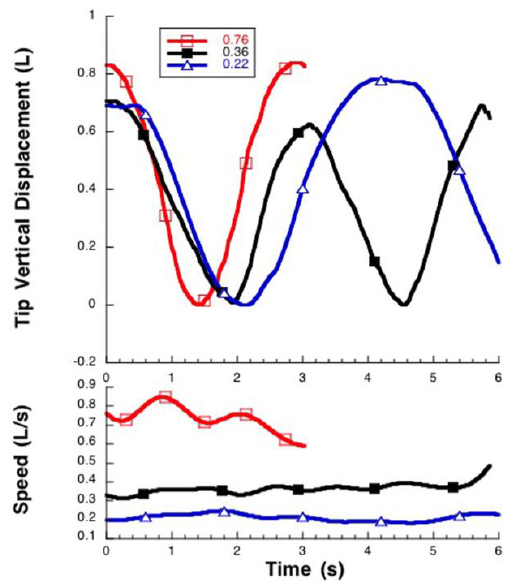
Figure 8. Comparison of vertical displacements of fin tip and swimming speeds for mantas over time. The average swimming speeds displayed for individual mantas were 0.29 (blue), 0.36 (black) and 0.76 (red) BL /s.